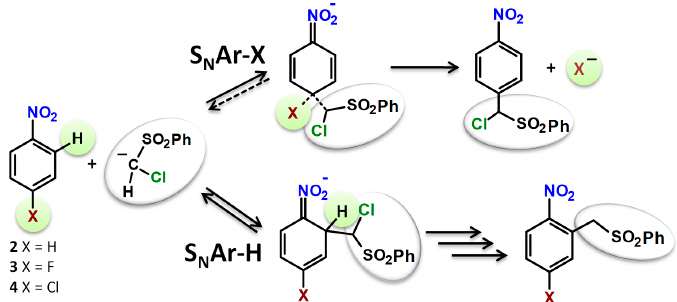
Figure 1. Potential energy profiles for the limiting step of S N Ar-H ( left ) and S N Ar-X ( right ) reactions between model nuclephile 1 and para substituted halonitrobenzenes constructed based on our previous computation results published elsewhere [35].